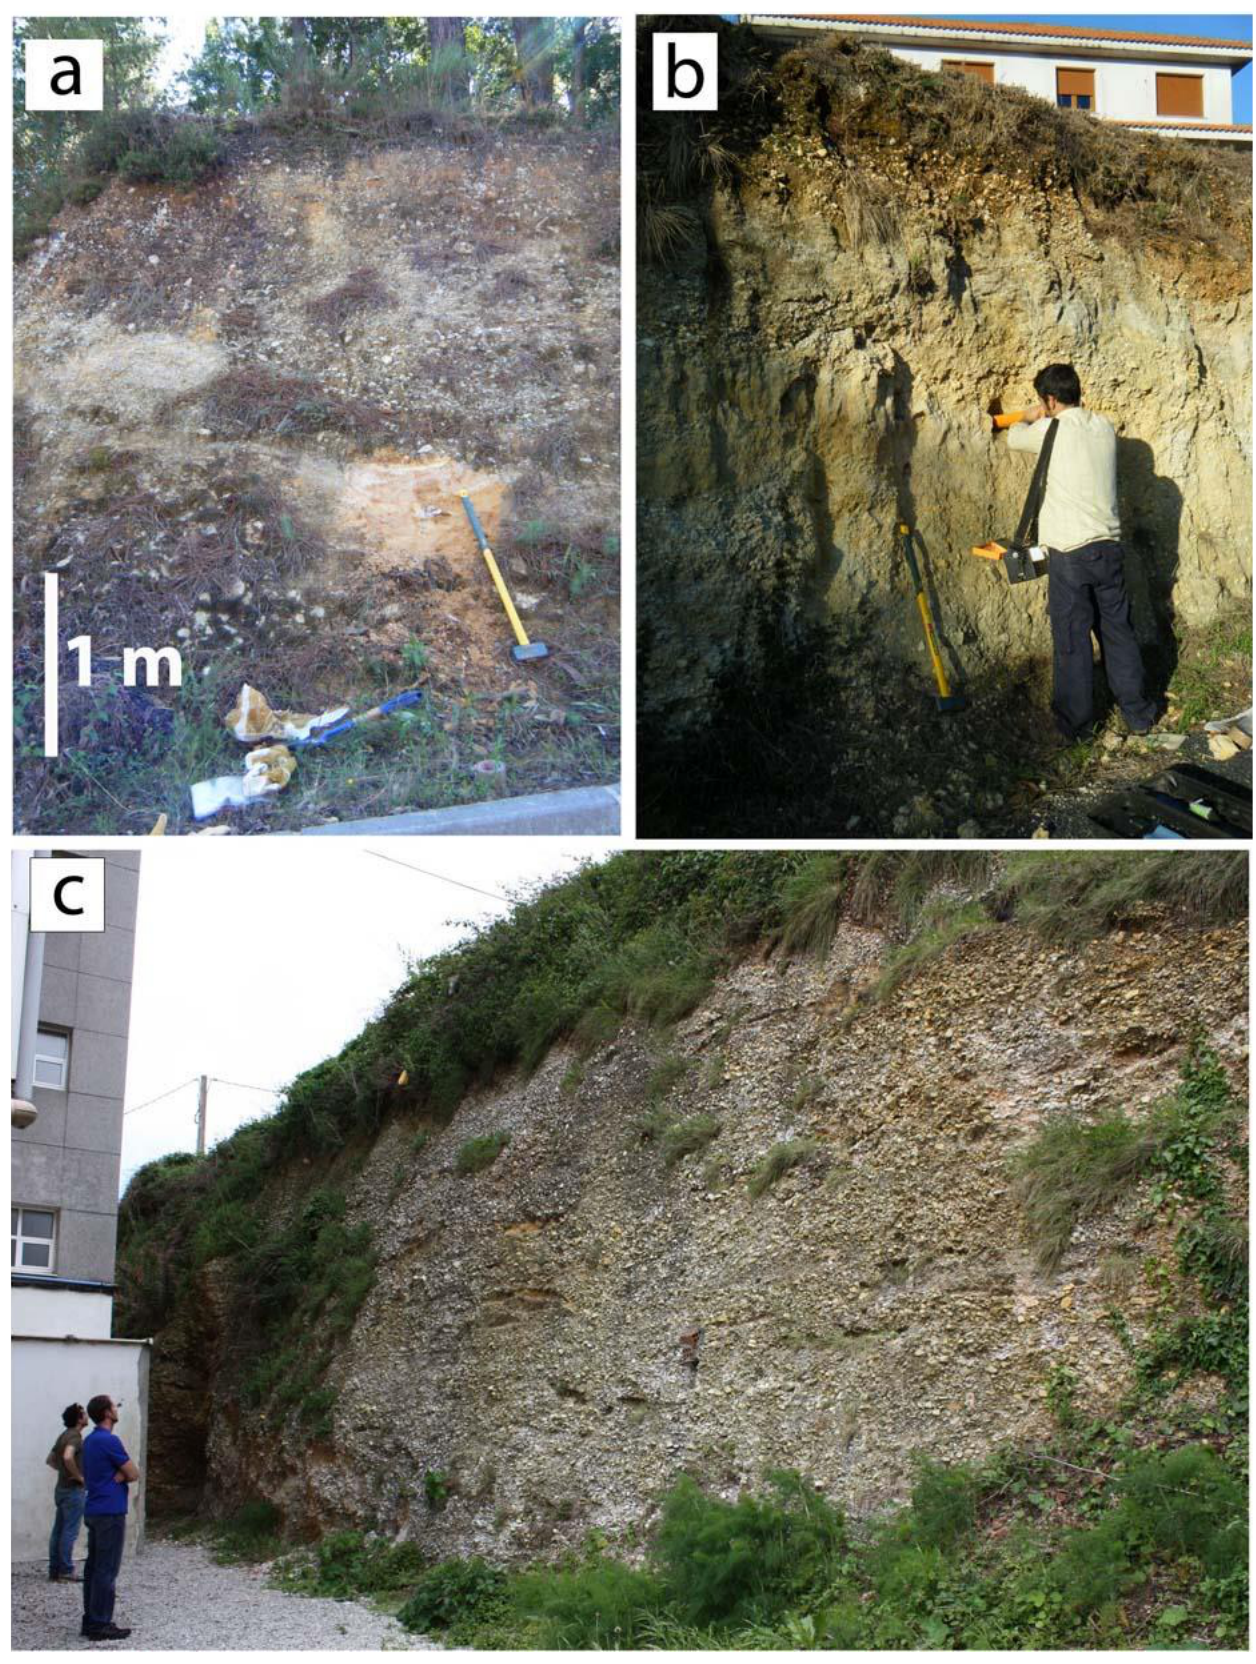
Figure 2. Alluvial deposits in the Mero basin. Outcrops: Mero-1 ( a ), Mero-3 ( b ) and Mero-2 ( c ).